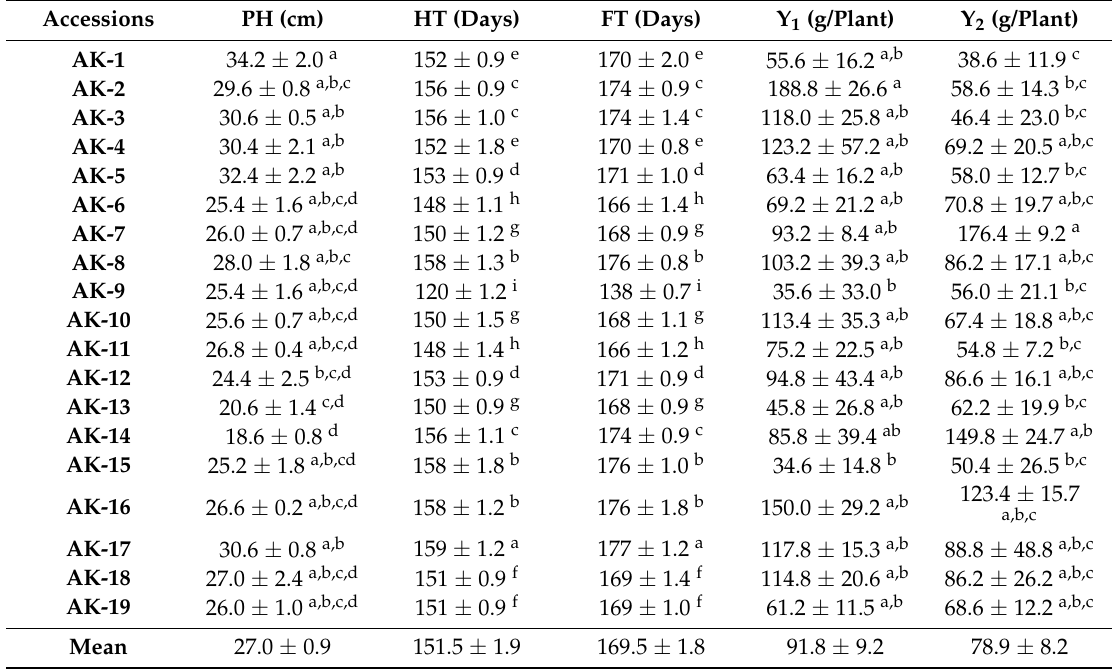
Table 4. Comparison of individual Apulian kale accessions for plant height (PH), first harvesting time (HT), flowering time (FT), and edible yield per plant at the first two harvests (Y 1 and Y 2 ). Values represent means ± standard